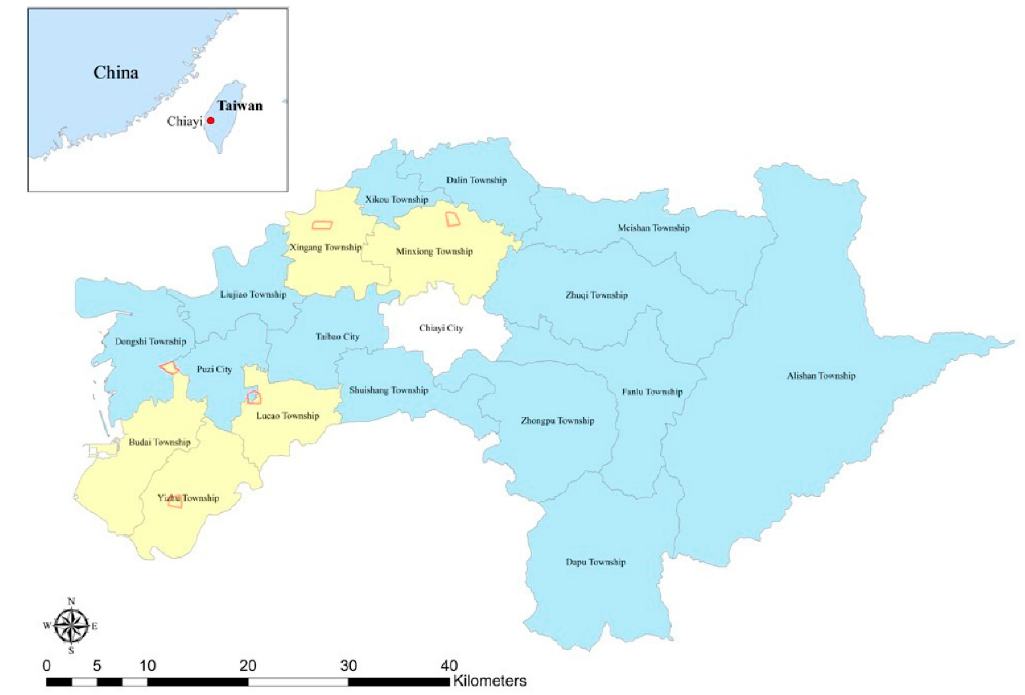
Figure 1. Distribution of sampling sites.